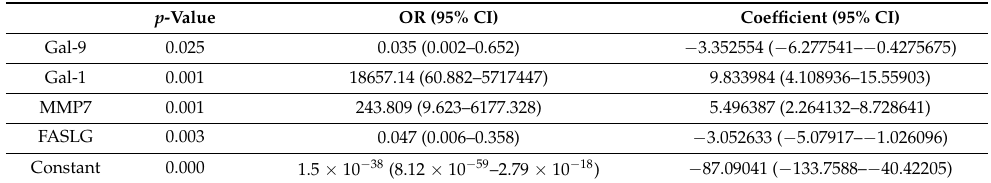
Table 3. Immuno-oncology panel: result of the stepdown procedure applied to the saturated multi- variate logistic regression